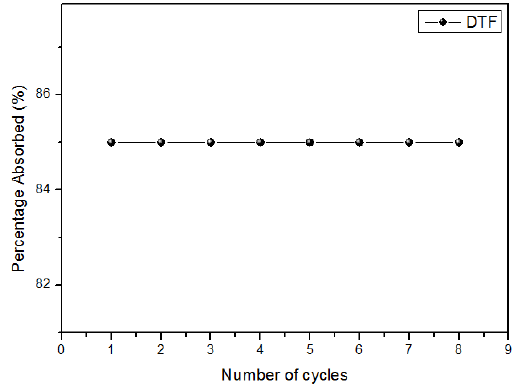
Figure 13. Percentage of DTF absorbed after a repeated number of cycles.